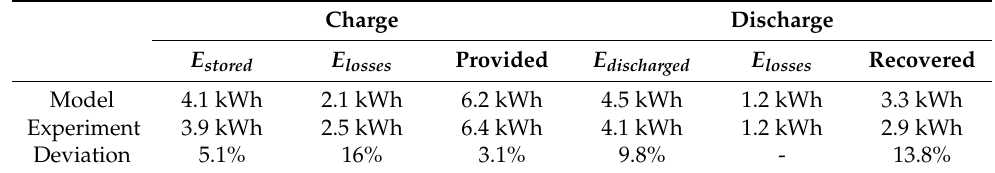
Table 6. Energy balance—model and experiment comparison. Case study: 2 °C/h, charge 43.0 - 69.9 °C at 180 L/h and discharge 62.1 - 40.8 °C at 194 L/h .